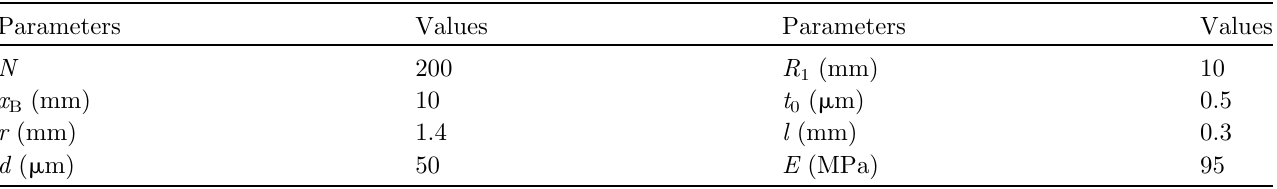
Table 1. Parameters of the system.